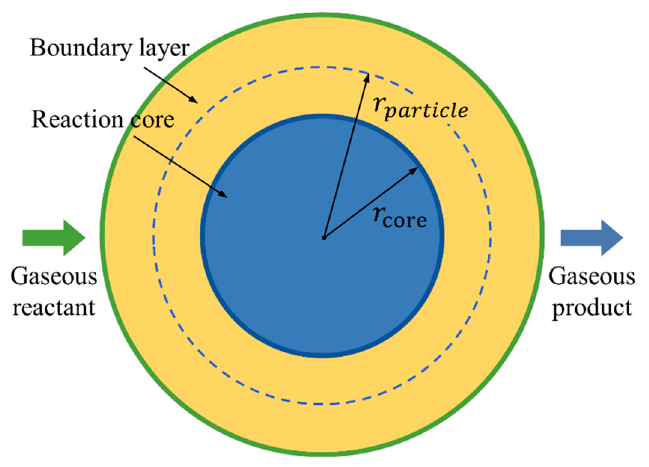
Figure 4. Gas-solid chemical reaction process in